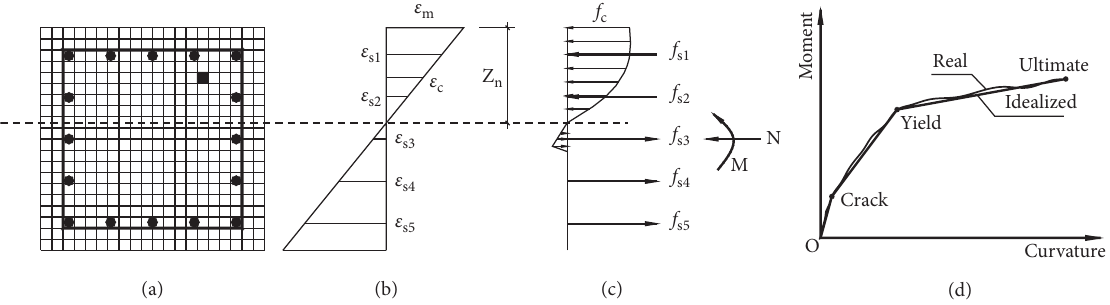
Figure 3: Section analysis using fibre model: (a) discretization, (b) strain, (c) stresses, and (d) moment-curvature.